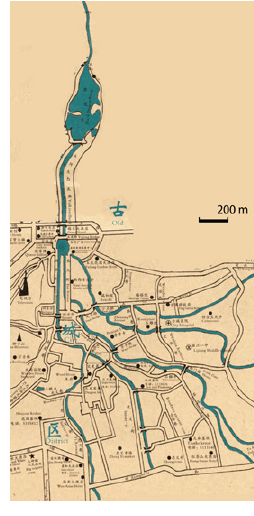
Figure 7. A map of Dayan, historical town in the Naxi’s region with streams marked (Baomanfeng